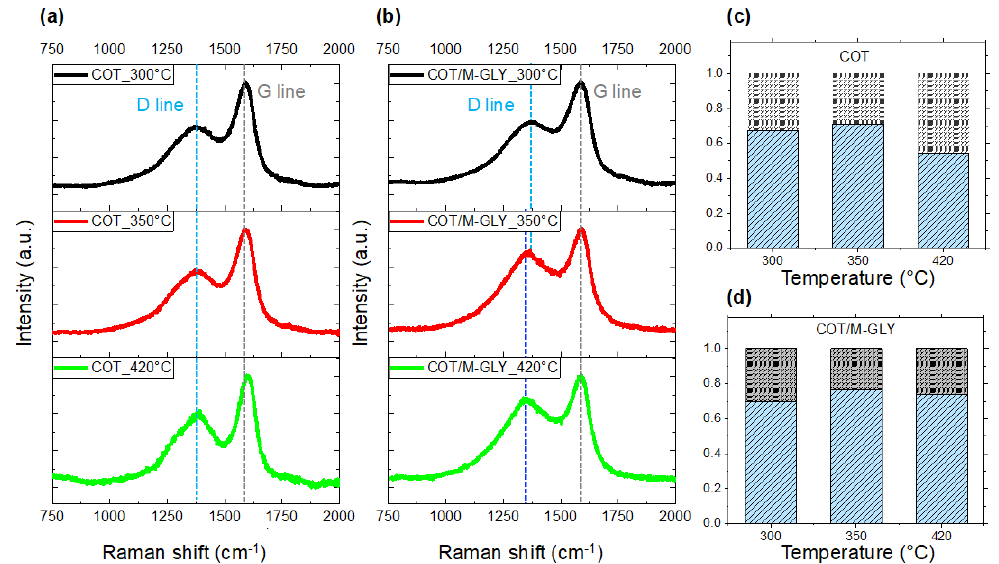
Figure 7. Progression of the normalized Raman spectra with temperature for untreated cotton (COT) ( a ) and 4% addon M-GLY-treated cotton (COT/M-GLY) ( b ). The position of the D and G lines are highlighted by the blue and grey broken lines, respectively. Proportion of the D and G lines for the cotton (COT) ( c ) and COT/M-GLY ( d ) series. 13 C SSNMR spectra were recorded on residues of COT and COT/M-GLY after heating